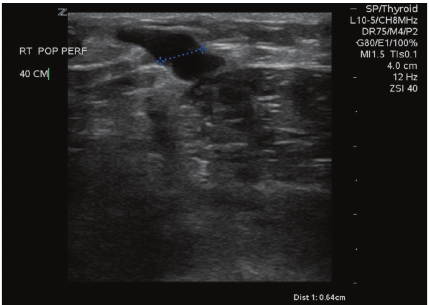
Figure 2: Popliteal fossa vein entering the deep fascia 40 cm from the medial malleolus, 6.4 mm at the fascial plane.